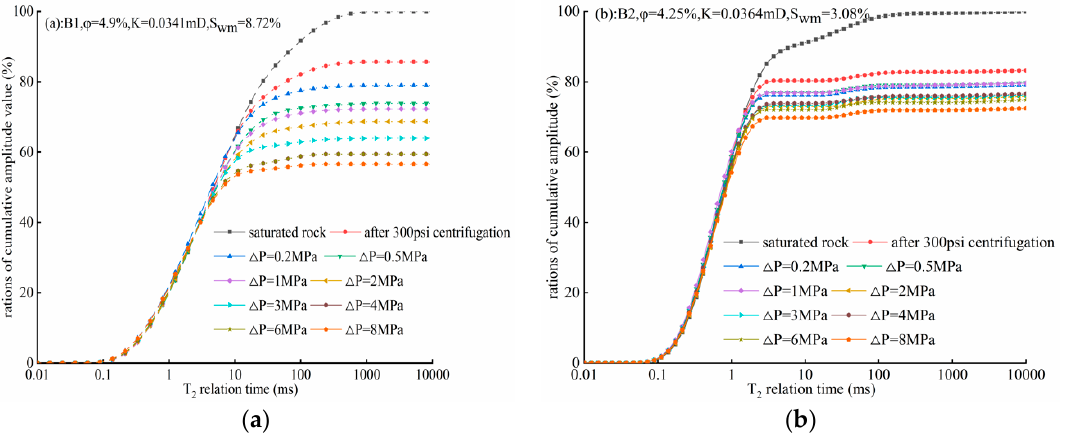
Figure 4. T 2 spectrum accumulation curve of tight sandstone cores under different differential pressures: ( a ) Core B1; ( b ) Core B2.